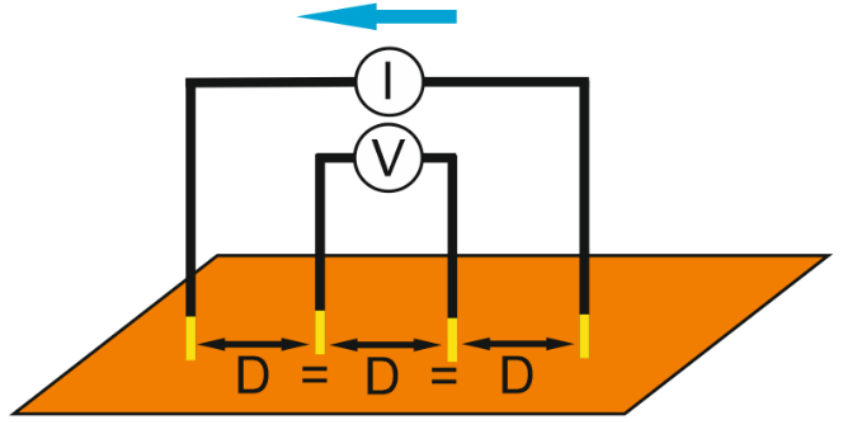
Figure 3. Sheet resistance measurement setup.